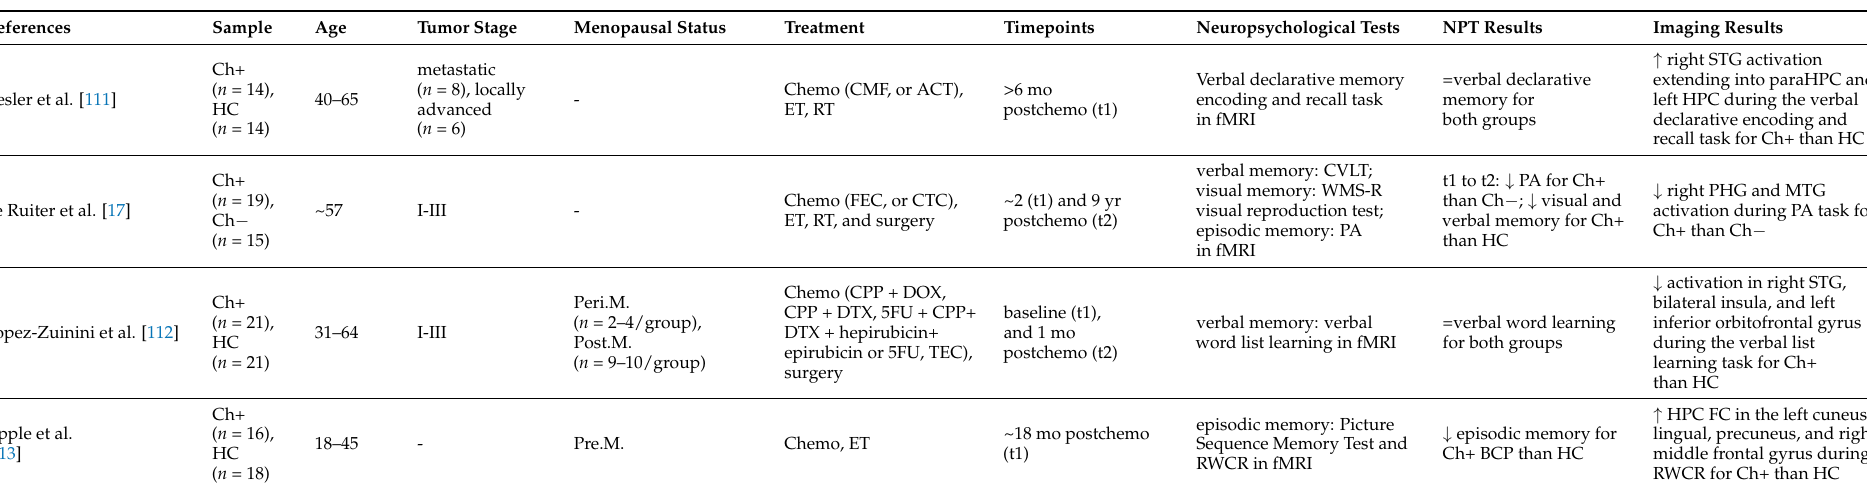
Table 2. Summary of reports identifying chemotherapy-induced functional differences in the temporal lobes and memory disruption in breast cancer survivors using task-based